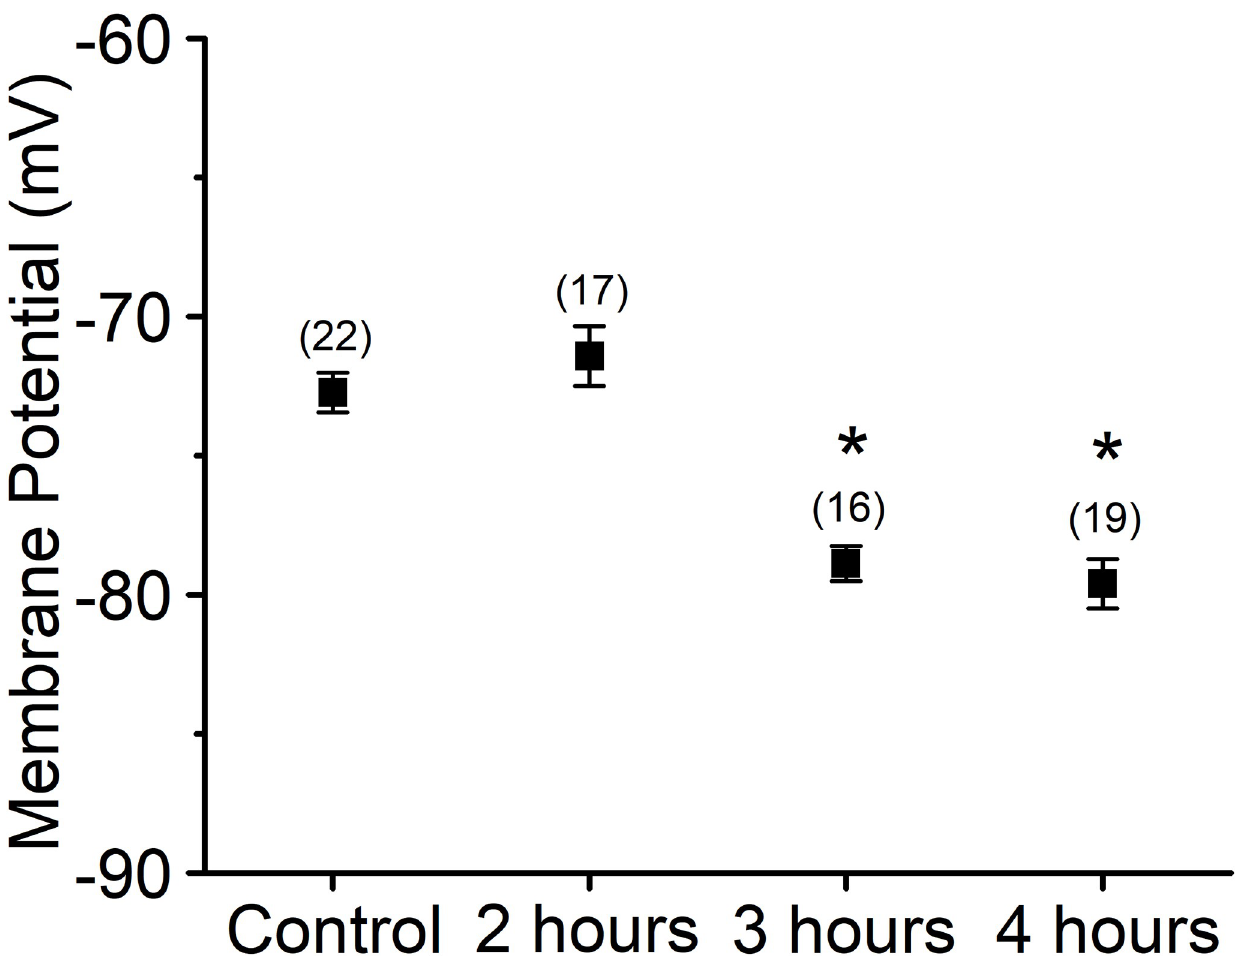
Fig 1. Peptide Lv hyperpolarizes the membrane potential of ECs. HUVECs were seeded onto glass coverslips and kept in an incubator for 48 hours to allow the cells to adhere. Cells were then treated with PBS (vehicle control) or peptide Lv (500 ng/ml) for 2, 3, or 4 hours prior to whole-cell current-clamp recordings. Membrane potentials were significantly hyperpolarized after treatments with peptide Lv (3 hr: -78.88 ± 0.63 mV and 4 hr: -79.61 ± 0.88 mV, respectively) compared to the PBS-treated controls (-72.73 ± 0.71 mV). Treatment with peptide Lv for 2 hours did not affect the EC membrane potential significantly (-71.42 ± 1.07 mV). One-way ANOVA followed with Tukey post hoc tests were used for statistical analyses; n = 16–19 for each group; � p <